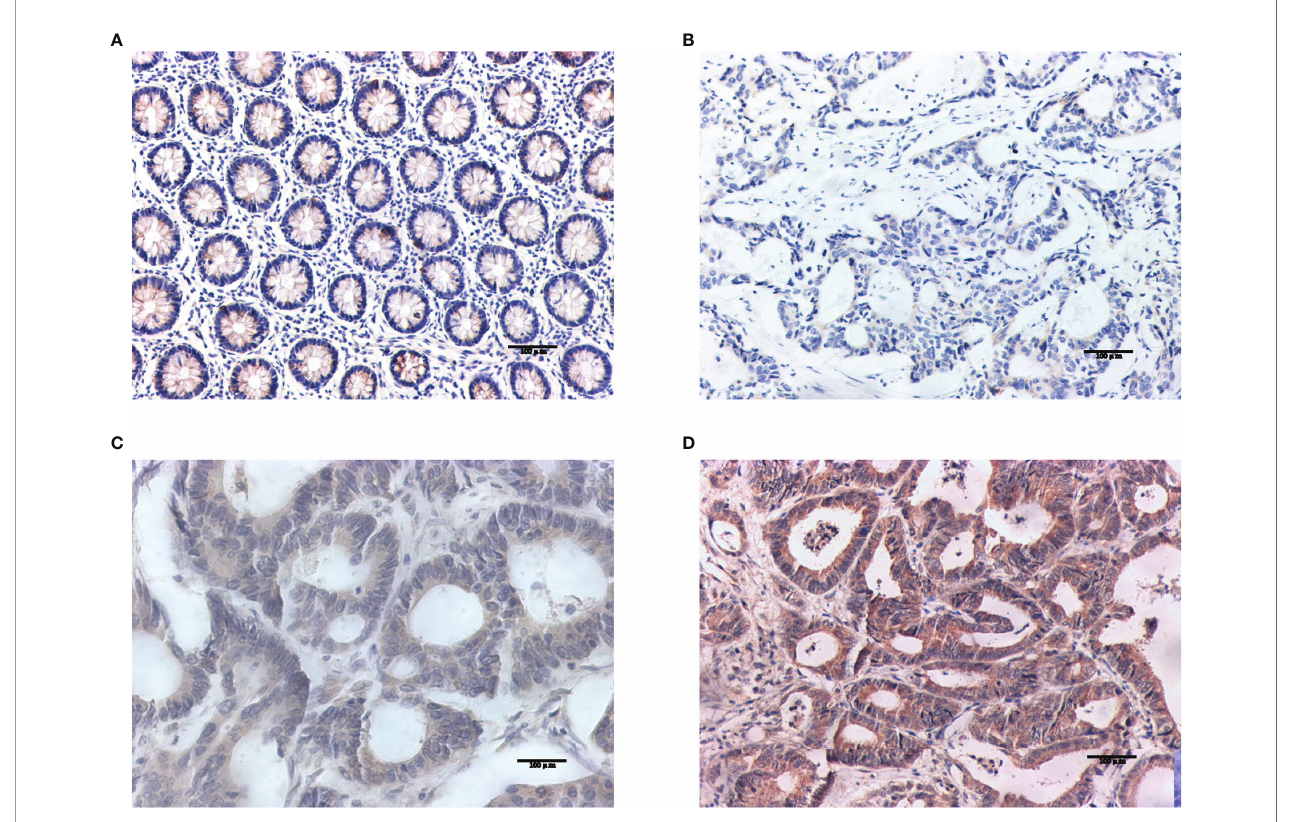
FIGURE 14 | Results of ALOXE3 immunohistochemistry. (A) Negative expression of ALOXE3 in normal tissues. (B – D) The weak positive, moderate strong positive and strong positive expression of ALOXE3 in tumor tissues, in turn.